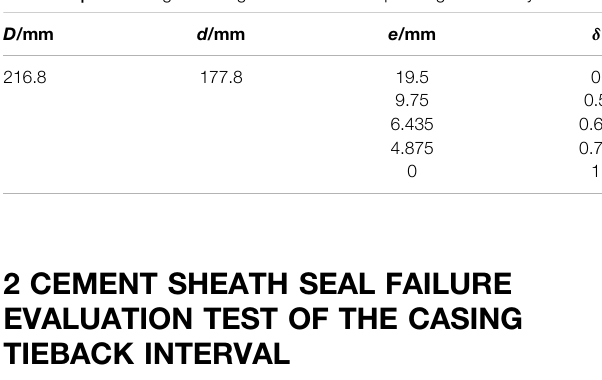
Frontiers in Energy Research |